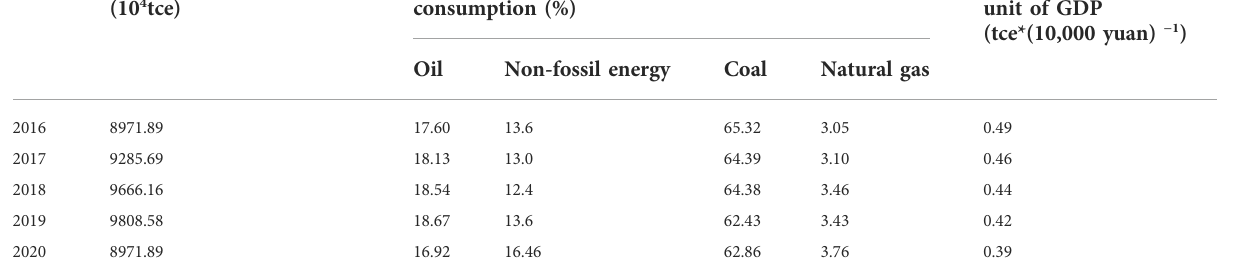
TABLE 2 Energy consumption data of Jiangxi Province, China from 2016 to 2020.